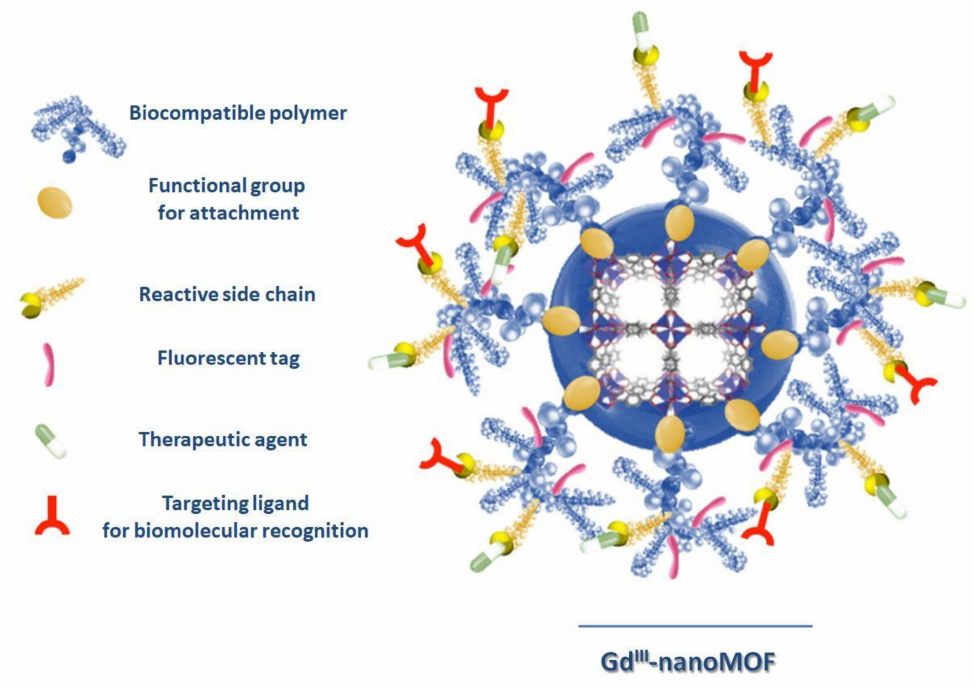
Figure 4. Image of a polymer-functionalized Gd III MOF nanoparticle (shown in the middle) as a biomolecular nanocarrier for targeted imaging and cancer treatment. (Redrawn from [66], copyright 2020 from American Chemical Society, Washington, DC,